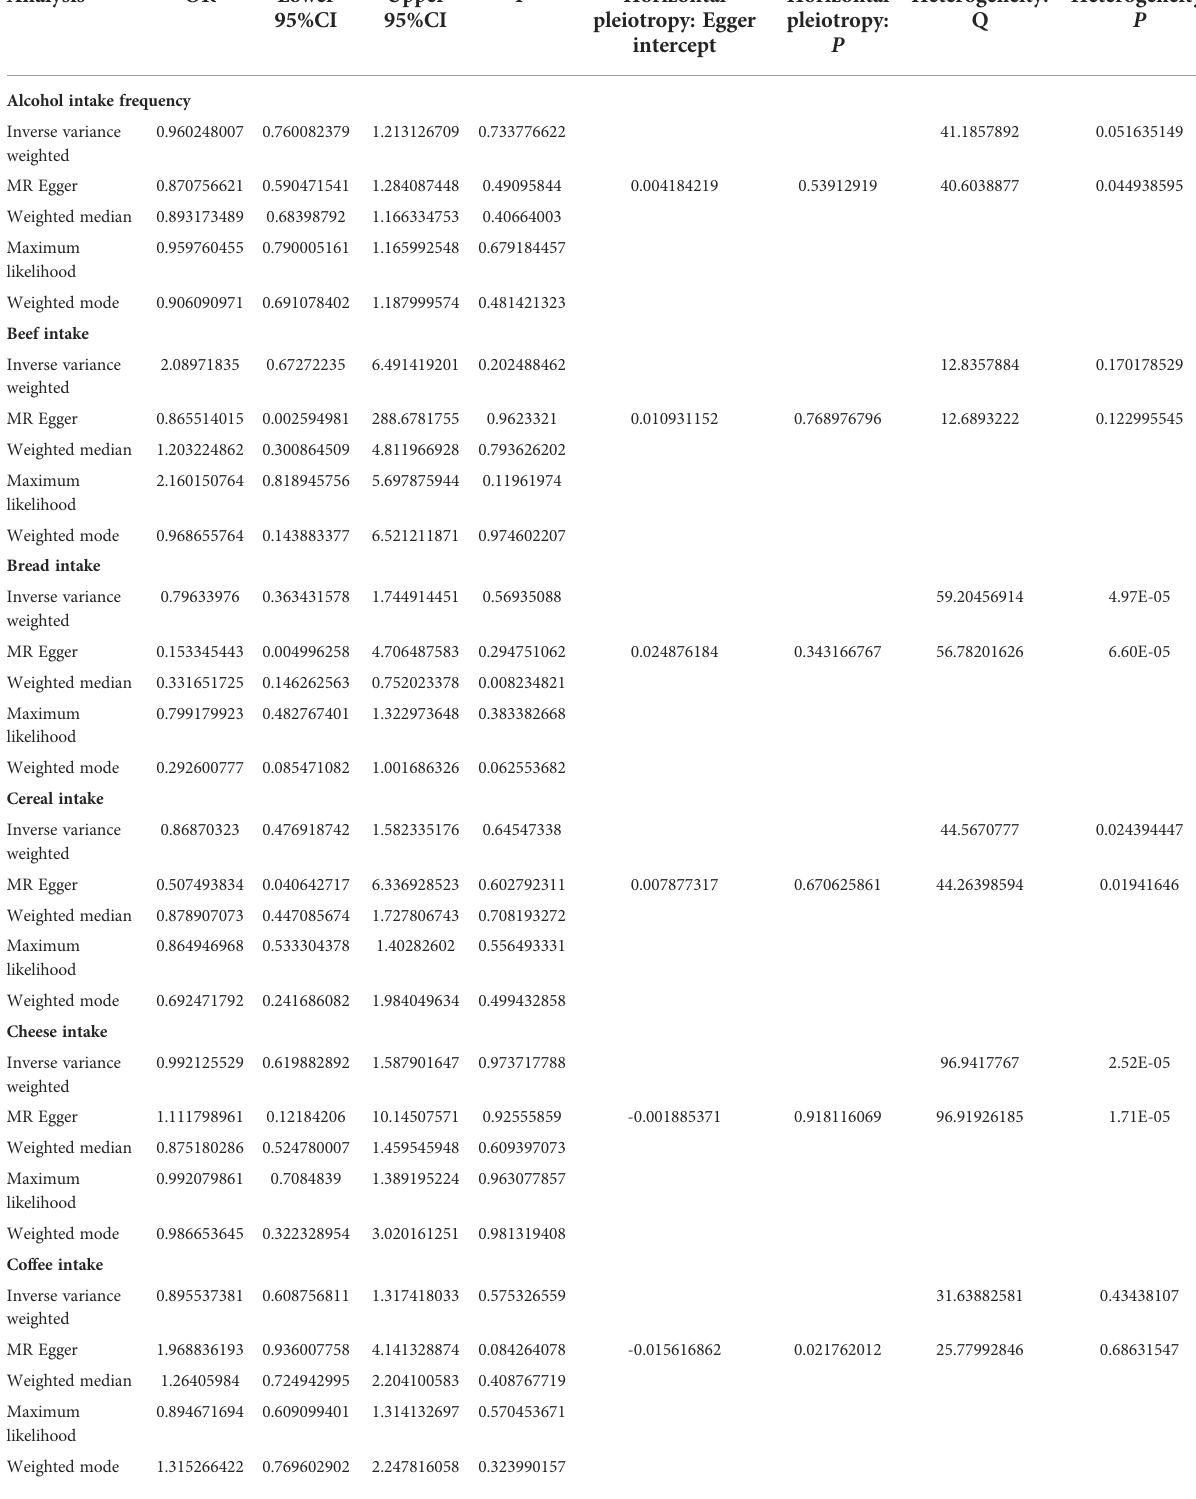
TABLE 4 Results of the MR study testing causal association between risk factors and